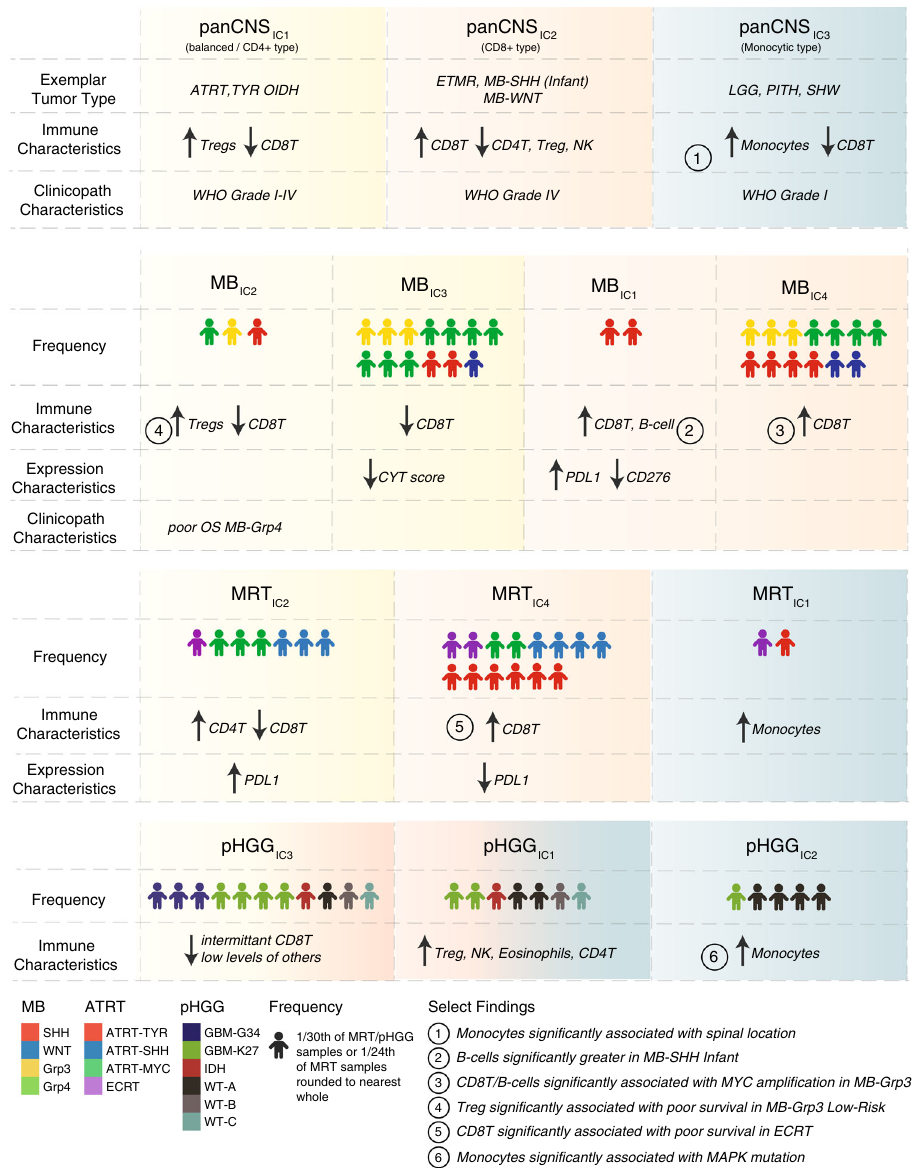
Fig. 6 Summary of immune clusters and associated characteristics. a Schematic representation of the broadly de fi ning features of immune clusters described in our analysis and a summary of select fi ndings. Icons show the relative frequency of immune cluster membership and the distribution of particular subgroups. Color shading represents broad similarities between the panCNS immune clusters and the more re fi ned tumor type-speci fi c immune clusters. Yellow broadly denotes a pattern of relatively increased CD4 + T in fi ltration with low – moderate levels of in fi ltration of other cell types and a lack of CD8 + T, a “ balanced/CD4 + type. ” Red broadly denotes a pattern of relatively increased CD8 + T in fi ltration, a “ CD8 + type, ” and blue broadly denotes a pattern of relatively increased in fi ltration of monocytes, a “ monocytic type ” . MRT IC3 is not shown here, as it represents only a small number of